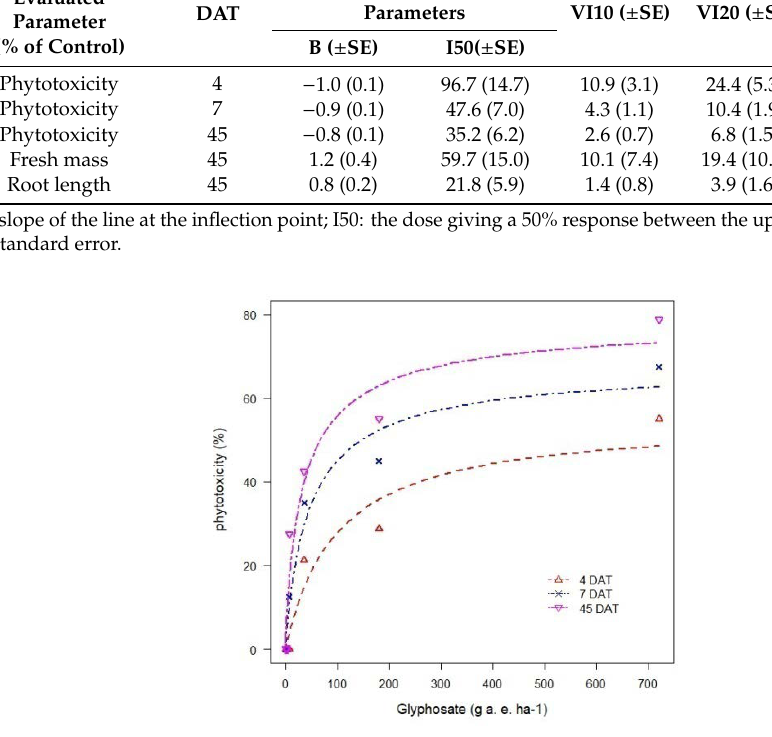
Figure 3. Phytotoxicity on soybean as influenced by glyphosate dose 4, 7, and 45 days after treatment (DAT). Table 1. Glyphosate doses g ha -1 that resulted in 10% (VI10), 20% (VI20) and 30%, ( VI30 ) for responses in soybean in the measured parameters (% of control) .